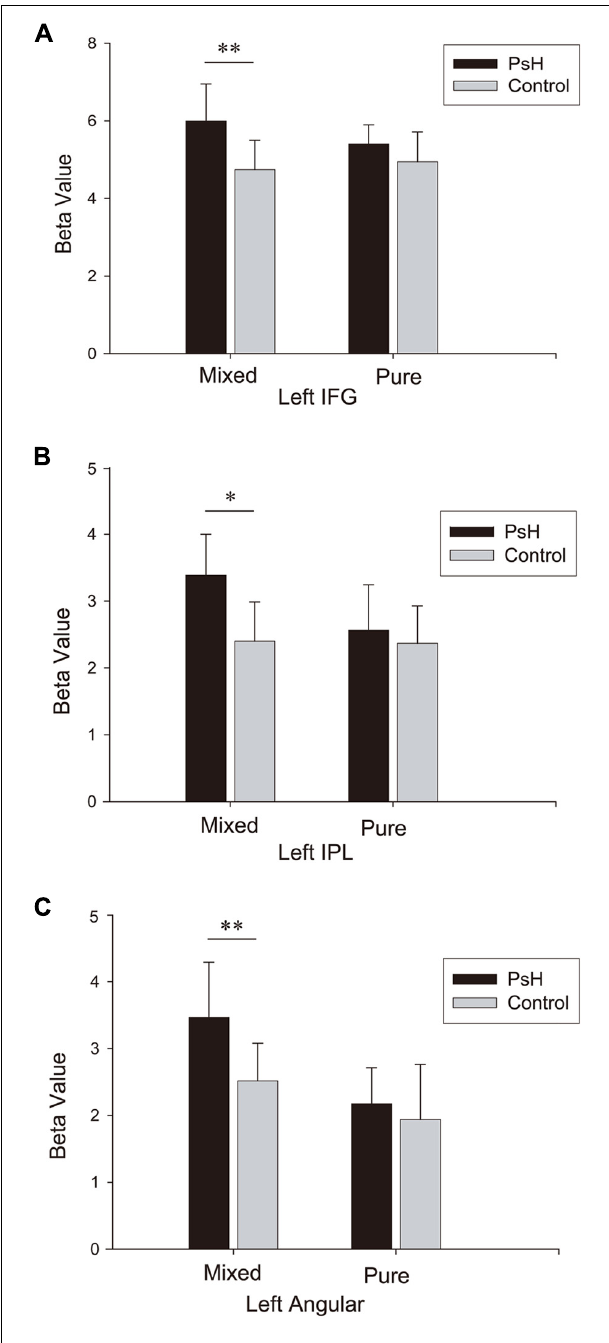
FIGURE 3 | Beta values for three regions of interest: left IFG (A), left IPL (B), and left angular gyrus (C), as revealed by the contrast “PsH >